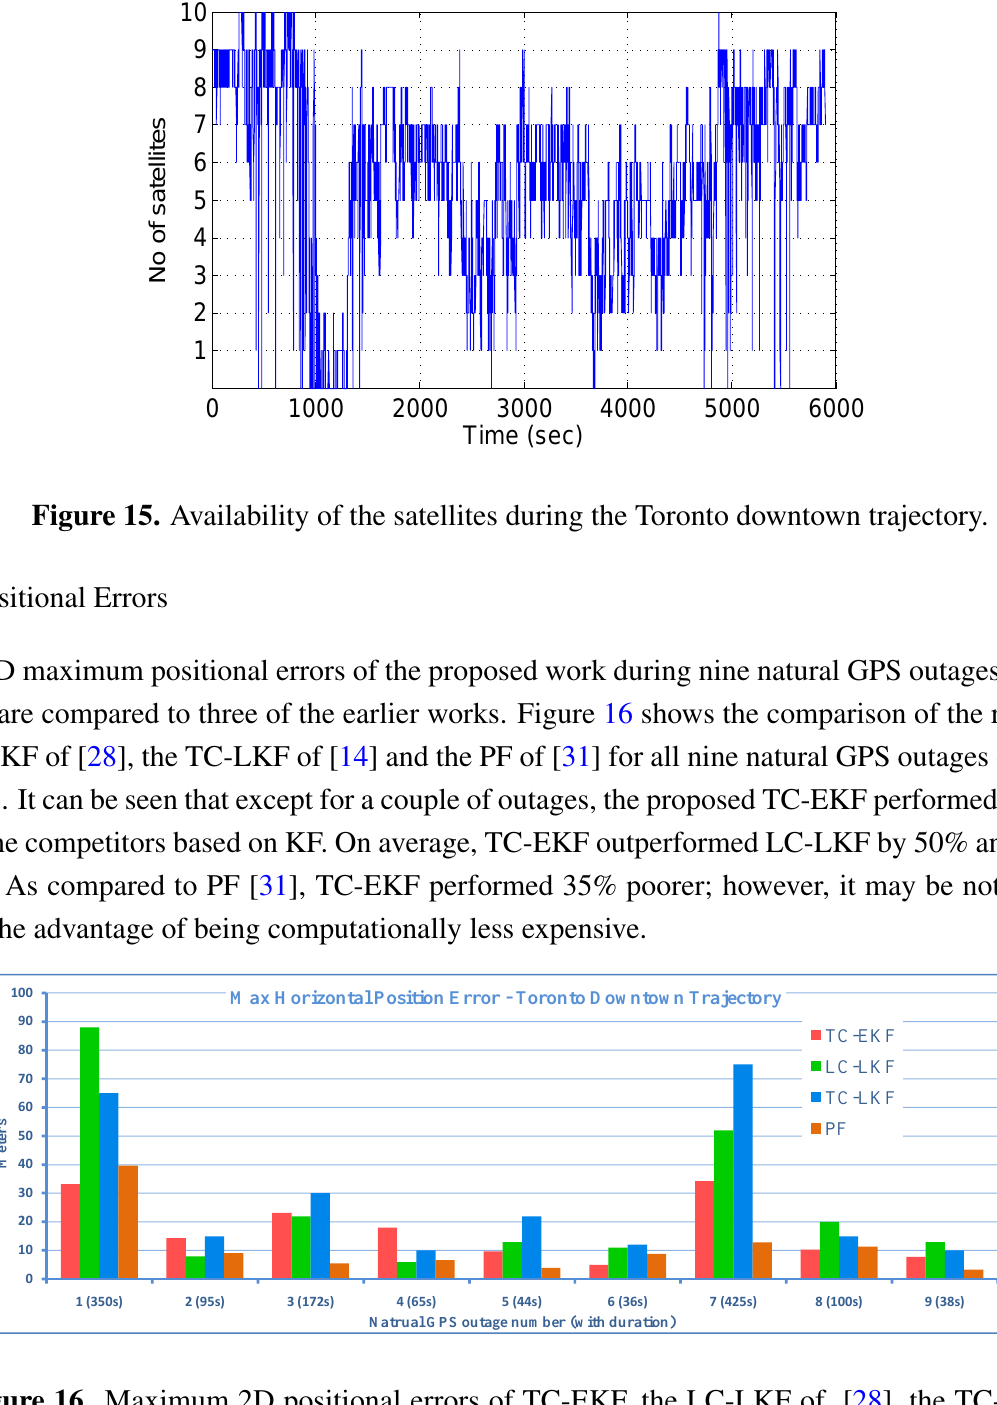
Figure 16. Maximum 2D positional errors of TC-EKF, the LC-LKF of [28], the TC-LKF of [14] and the PF of